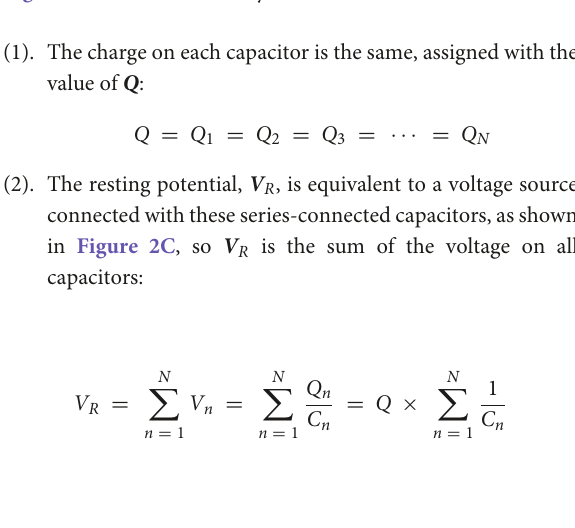
Here Q n is the charge on the capacitor. So the voltage, V 1 , on the first layer is V 1 = Q 1 C 1